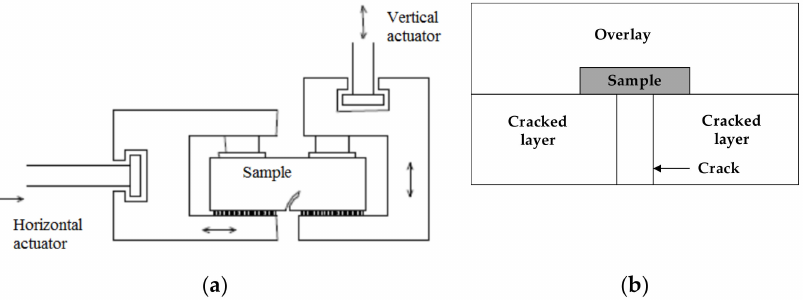
Figure 4. Schematic representation of the RCD and the crack zone. ( a ) RCD device. ( b ) Crack zone.